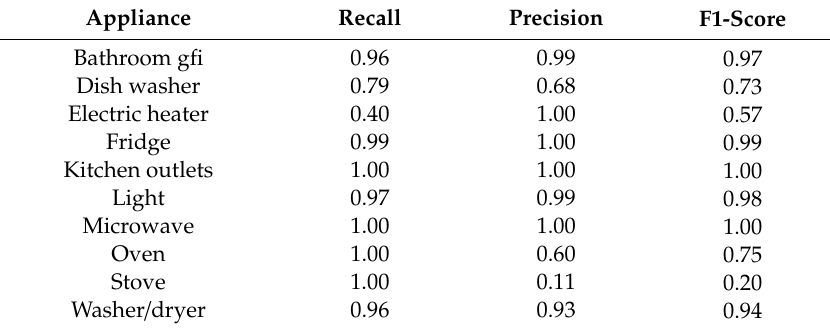
Table 3. Experimental results